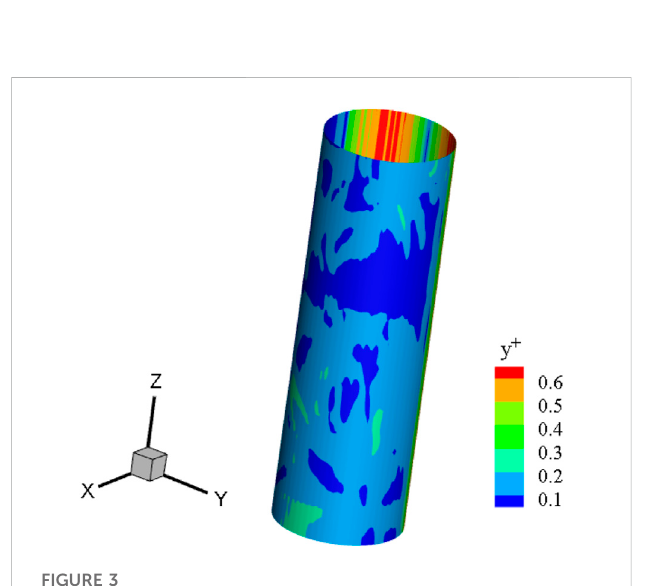
FIGURE 3 y + distribution of the circular cylinder.